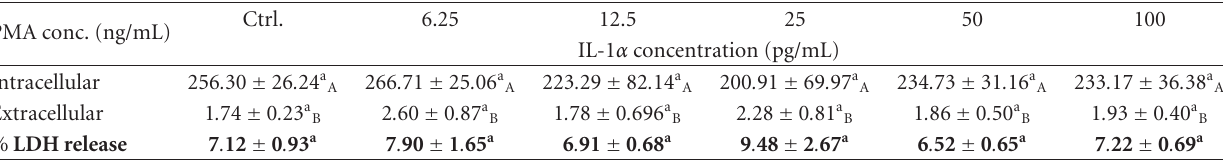
Cells were seeded at a density of 30 × 10 4 /well and incubated for 6h. Values represent the mean ± standard deviation of 6 replicates. Cytotoxicity represents LDH release as a percentage of the total. Letters in superscript indicated significant di ff erences between control and PMA concentration; letters in subscript indicated significant di ff erences between intracellular and extracellular IL-1 α production. P < 0 . 05 was considered significant. PMA: phorbol 12-myristate 13-acetate; LDH: lactate